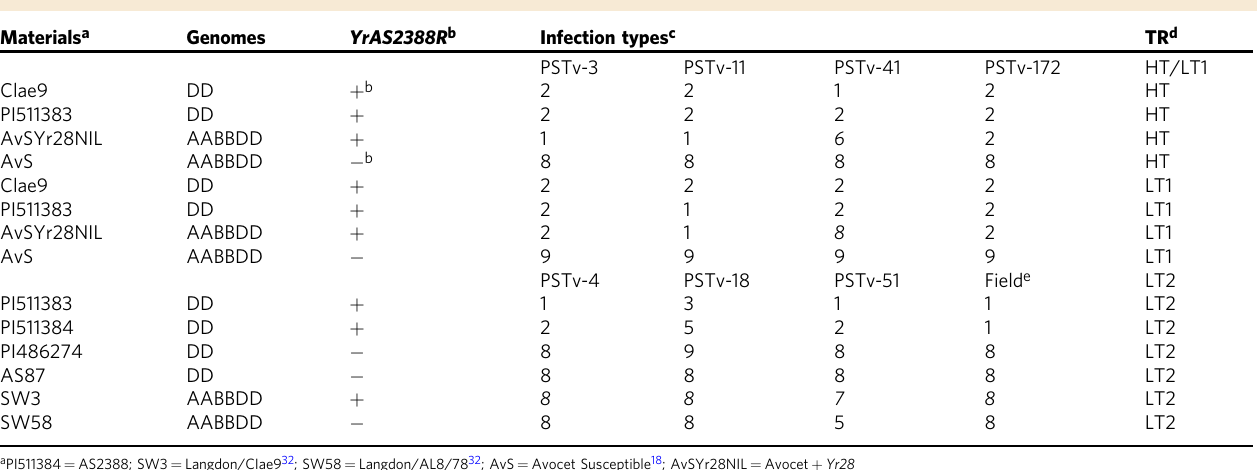
Table 1 Seedling responses of selected lines to Puccinia striiformis f. sp.